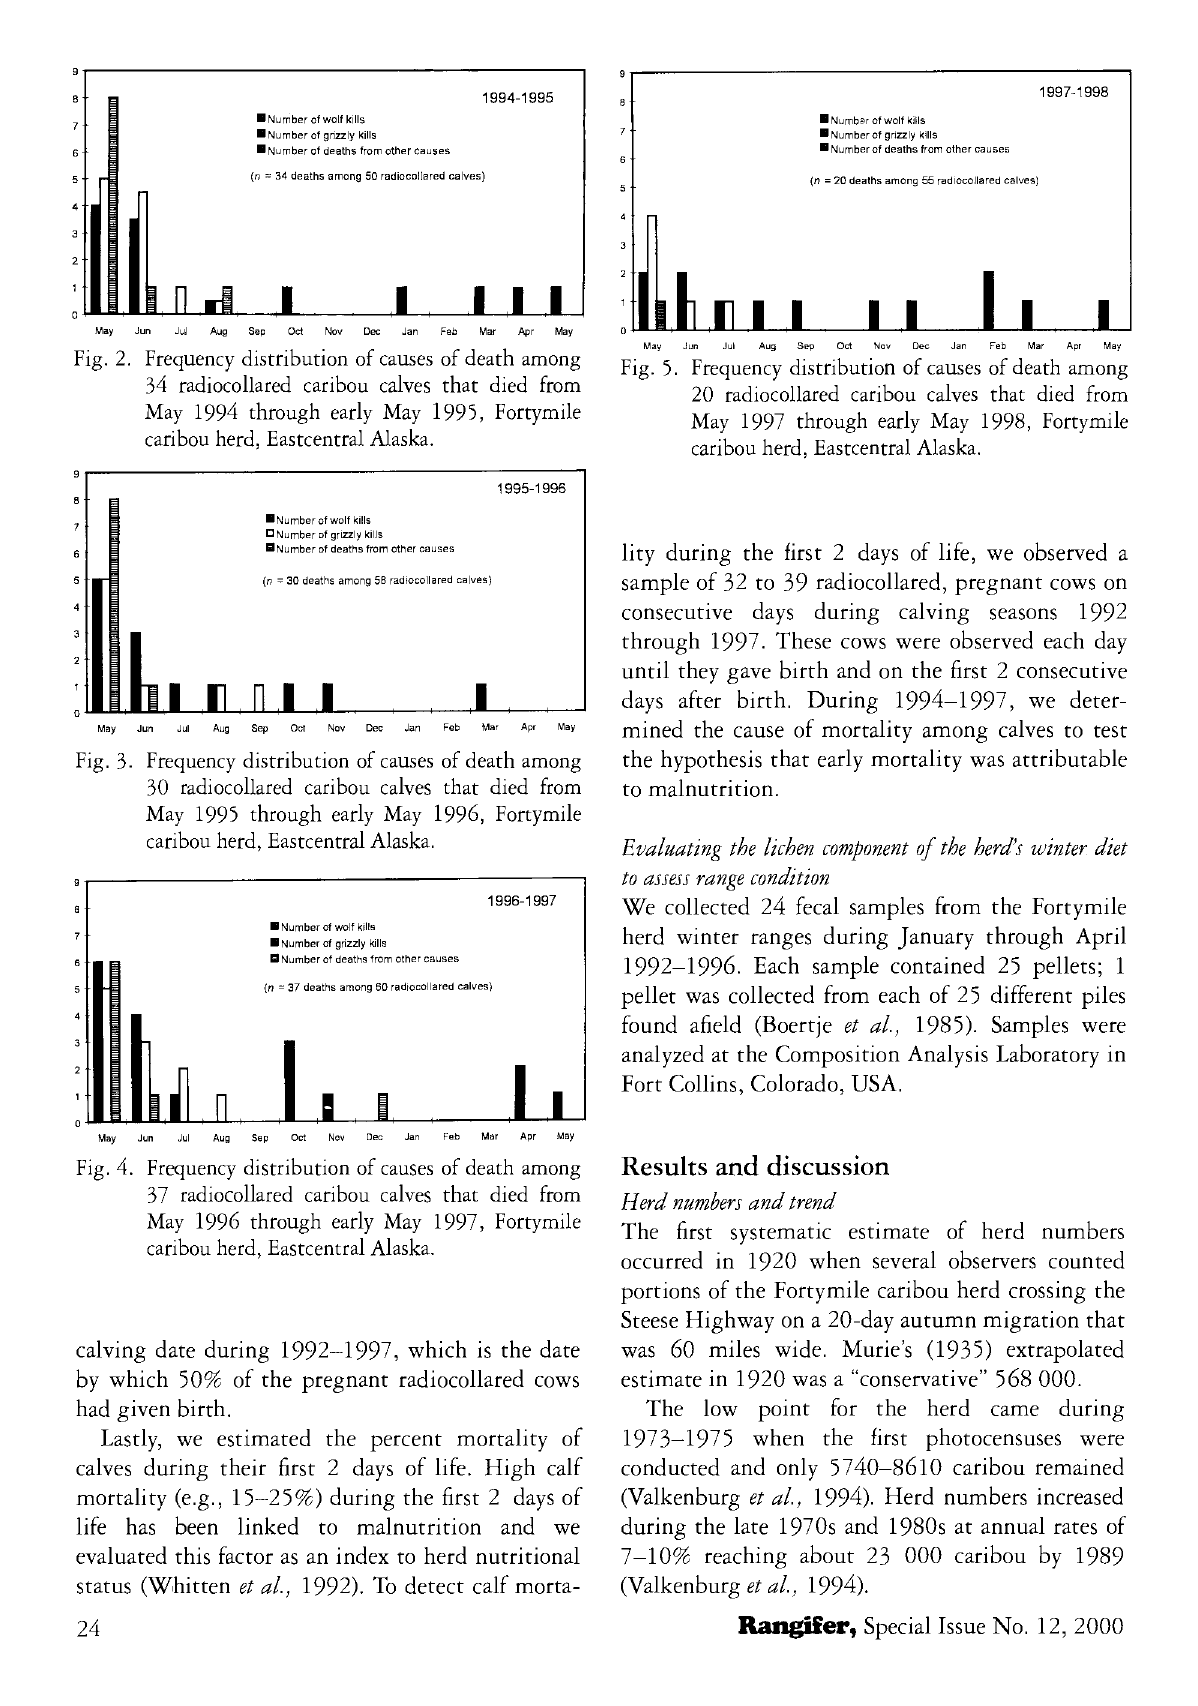
Fig. 5. Frequency distribution of causes of death among 20 radiocollared caribou calves that died from May 1997 through early May 1998, Fortymile caribou herd, Eastcentral